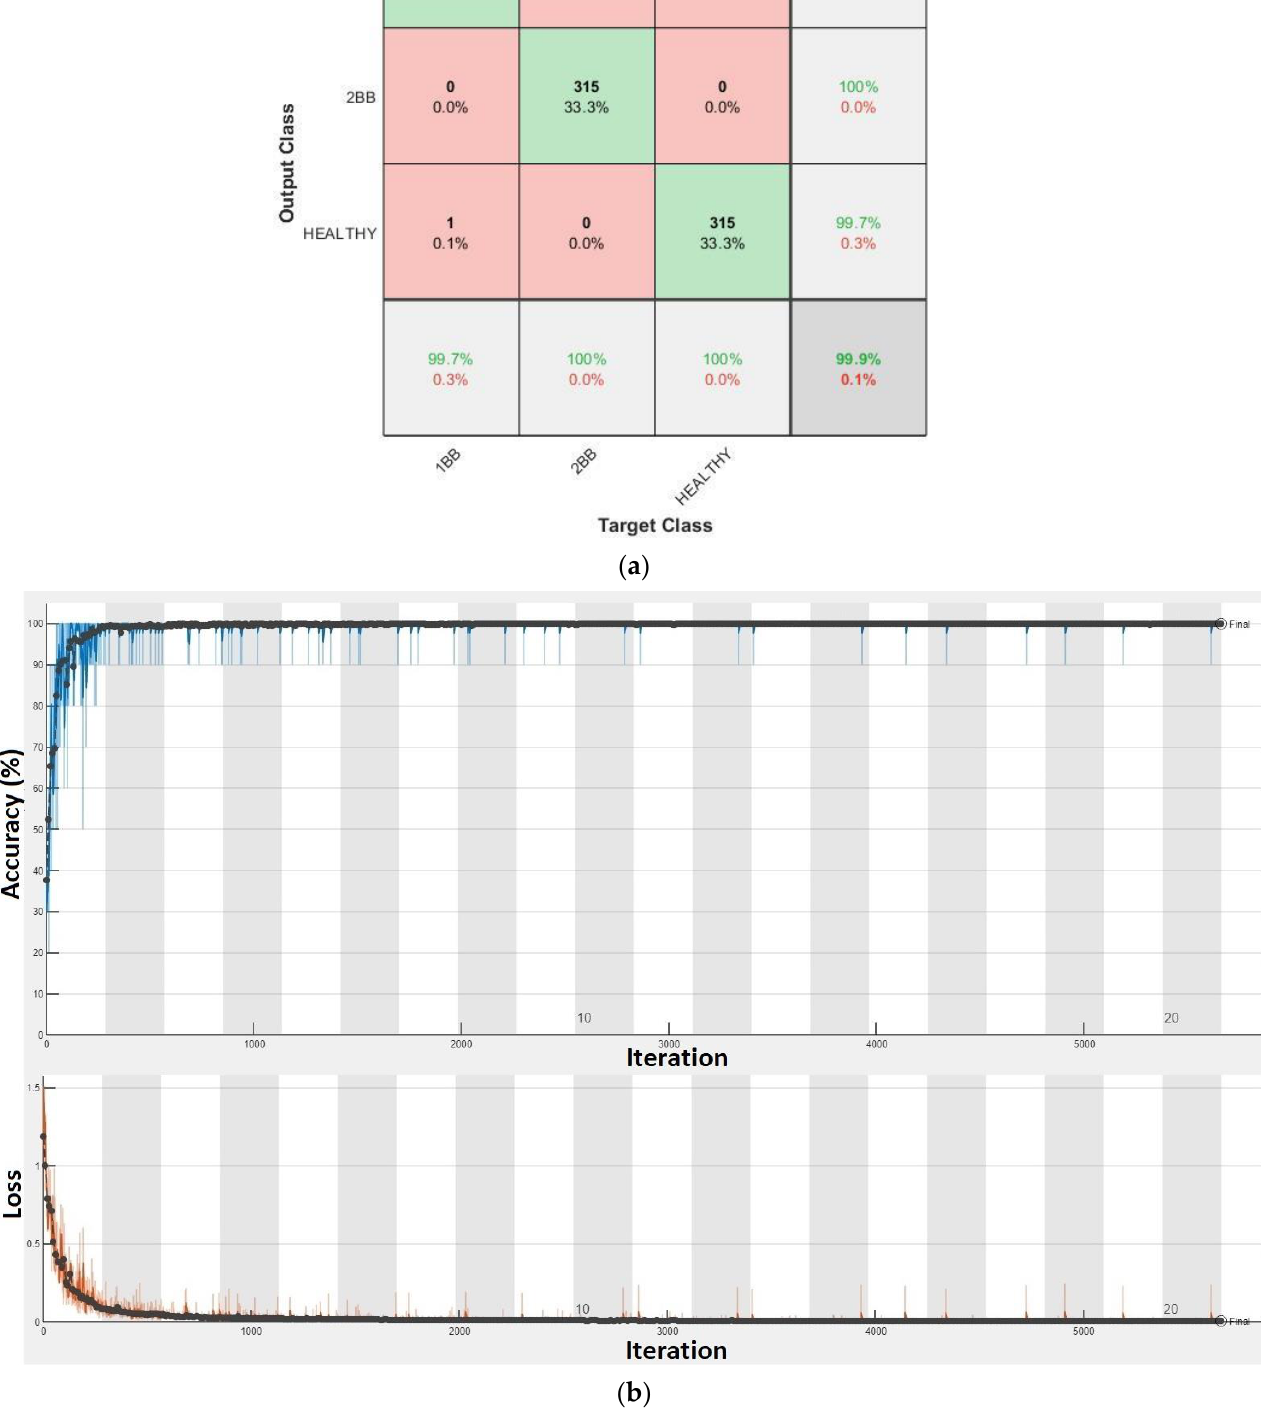
Figure 19. Results for all the models of soft starter combined: ( a ) Confusion matrix. ( b ) Training progress.